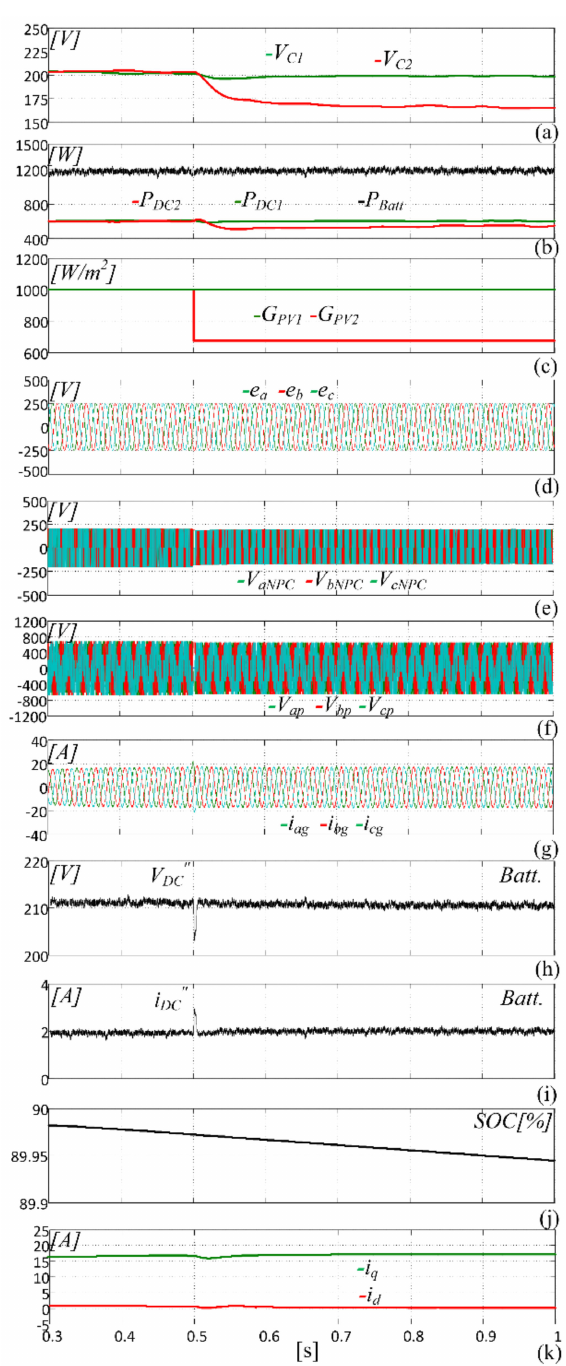
Figure 11. Six-level MMC- G PV 2 drop from 1000 W/m 2 to 700 W/m 2 . ( a ) String voltages V c 1 and V c 2 . ( b ) ES 1 , ES 2 , and energy storage system (ESS) output power. ( c ) G PV 1 and G PV 2 . ( d ) Grid voltage. ( e ) NPC output voltage. ( f ) Primary voltage. ( g ) Grid current. ( h ) Battery voltage. ( i ) Current. ( j ) State of charge ( SOC ). ( k ) Output d , q axes